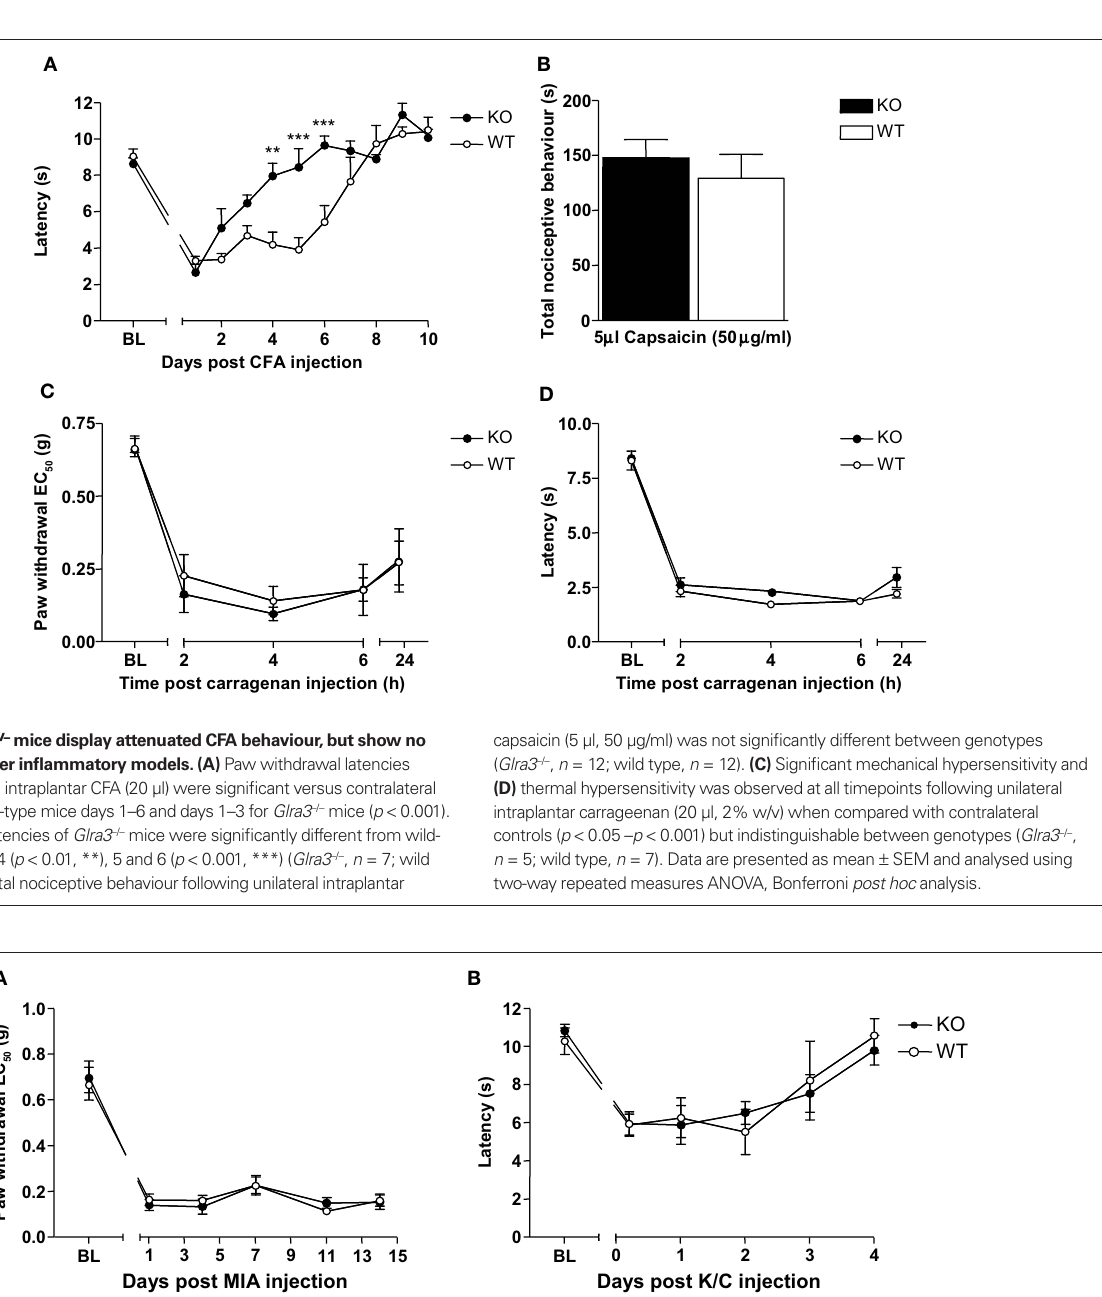
hypersensitivity was observed at days 1 and 2 following unilateral intra-articular K/C injection (15 µl, 3% w/v) in both genotypes when compared with contralateral controls ( n = 6; p < 0.05). No differences were observed between genotypes. Data are presented as mean ± SEM and analysed using two-way repeated measures ANOVA, Bonferroni post hoc analysis.